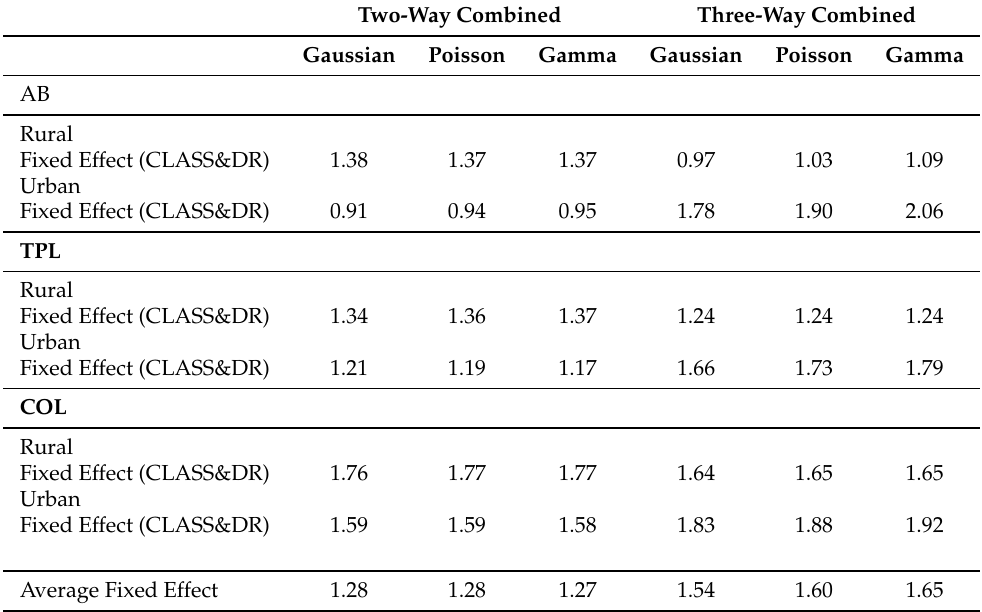
Table 9. The comparison of fixed effect between two-way and three-way analysis for three years of combined loss data, separated by coverages and